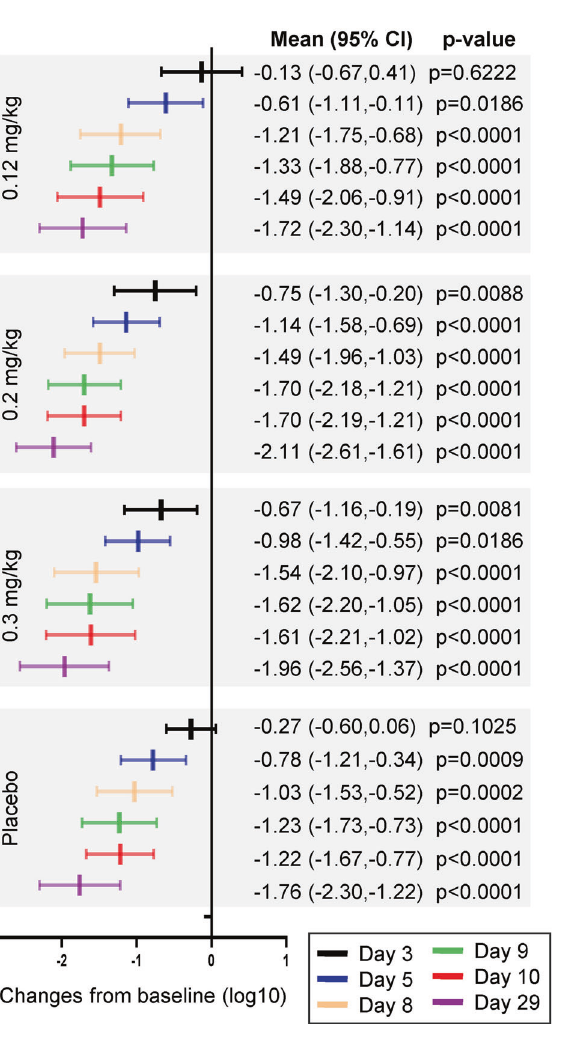
Signal Transduction and Targeted Therapy (2023)